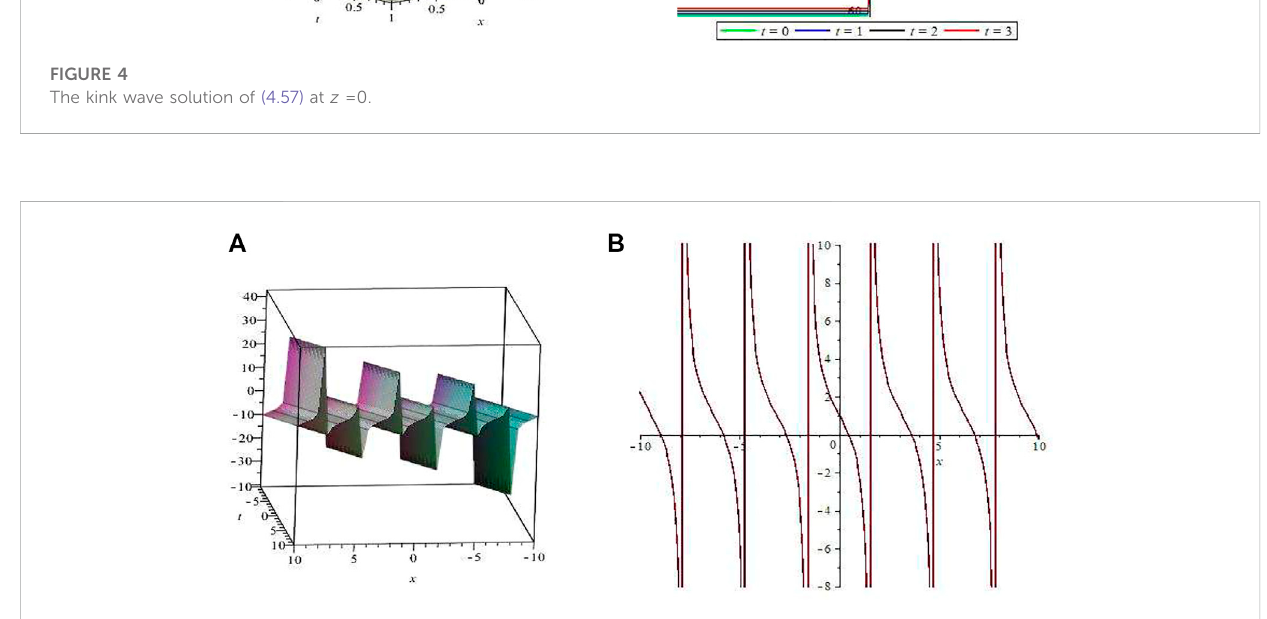
FIGURE 5 The periodic solution of (4.58) at z =0.